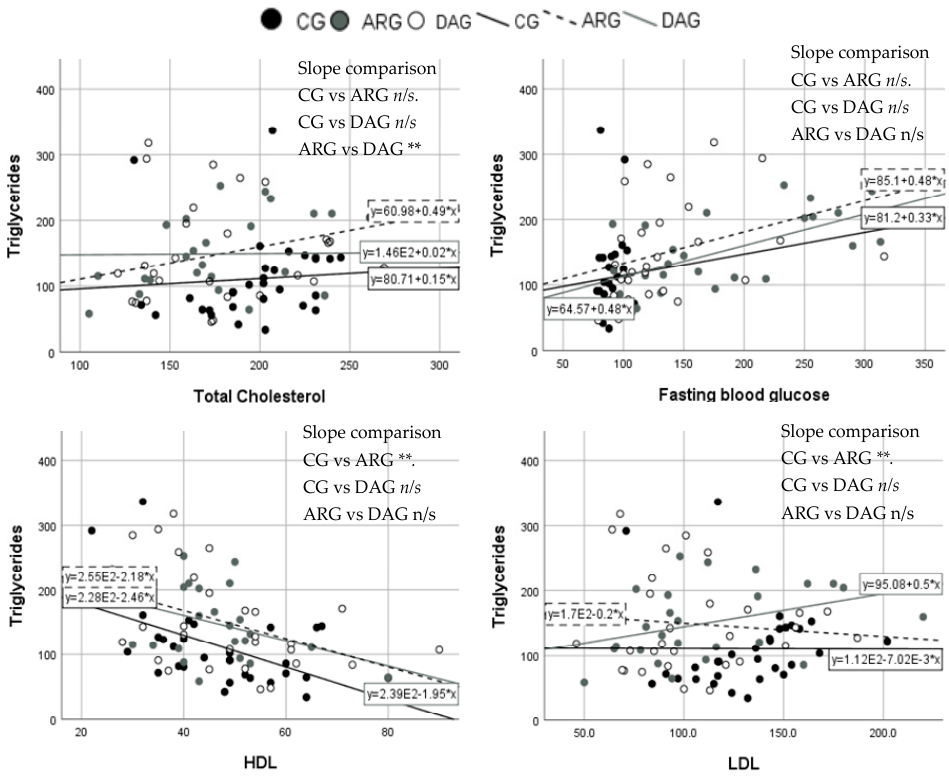
Figure 4. X–Y scatter plots of triglycerides (TG) (mg/dL) and the significantly correlated study markers between the clinical groups. For slope comparisons, * p < 0.05, ** p < 0.01, and n/s for non- significant difference in slopes. HDL—high-density lipoprotein; LDL—low-density